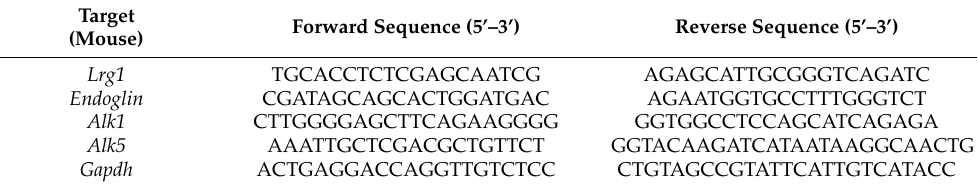
Table 1. Sequences of the forward and reverse primers utilized for gene expression